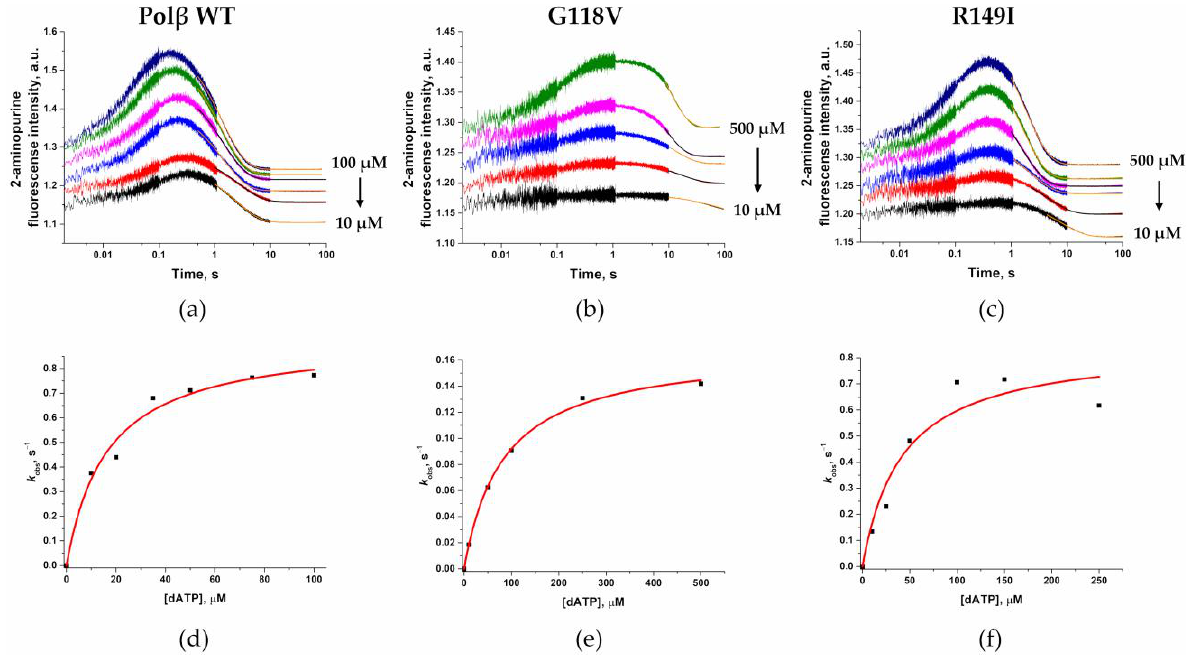
Figure 10. Changes in fluorescence intensity of the 2-aminopurine residue (present in the DNA substrate) upon interaction with WT Polβ ( a ), Gly118Val ( b ), or Arg149Ile ( c ) at various concentrations of dATP. Changes in dATP concentrations are shown in the figures. [Enzyme] = 1.0 μM, [DNA substrate] = 0.5 μM. Solid orange or black lines represent fitted part of curves. The dependence of the calculated values of the observed rate constants on the dATP concentration is shown in panels ( d ), ( e ), and ( f ) for WT Polβ, Gly118Val, and Arg149Ile, respectively. Table 4. The rate constant of the chemical step ( k pol ) and observed dissociation constant K d, app (dATP) . WT Pol β Pol β G118V Pol β R149I k pol , s − 1 0.93 ± 0.05 0.17 ± 0.01 0.9 ± 0.1 K d , app (dATP), µ M 16 ± 3 83 ± 6 42 ±